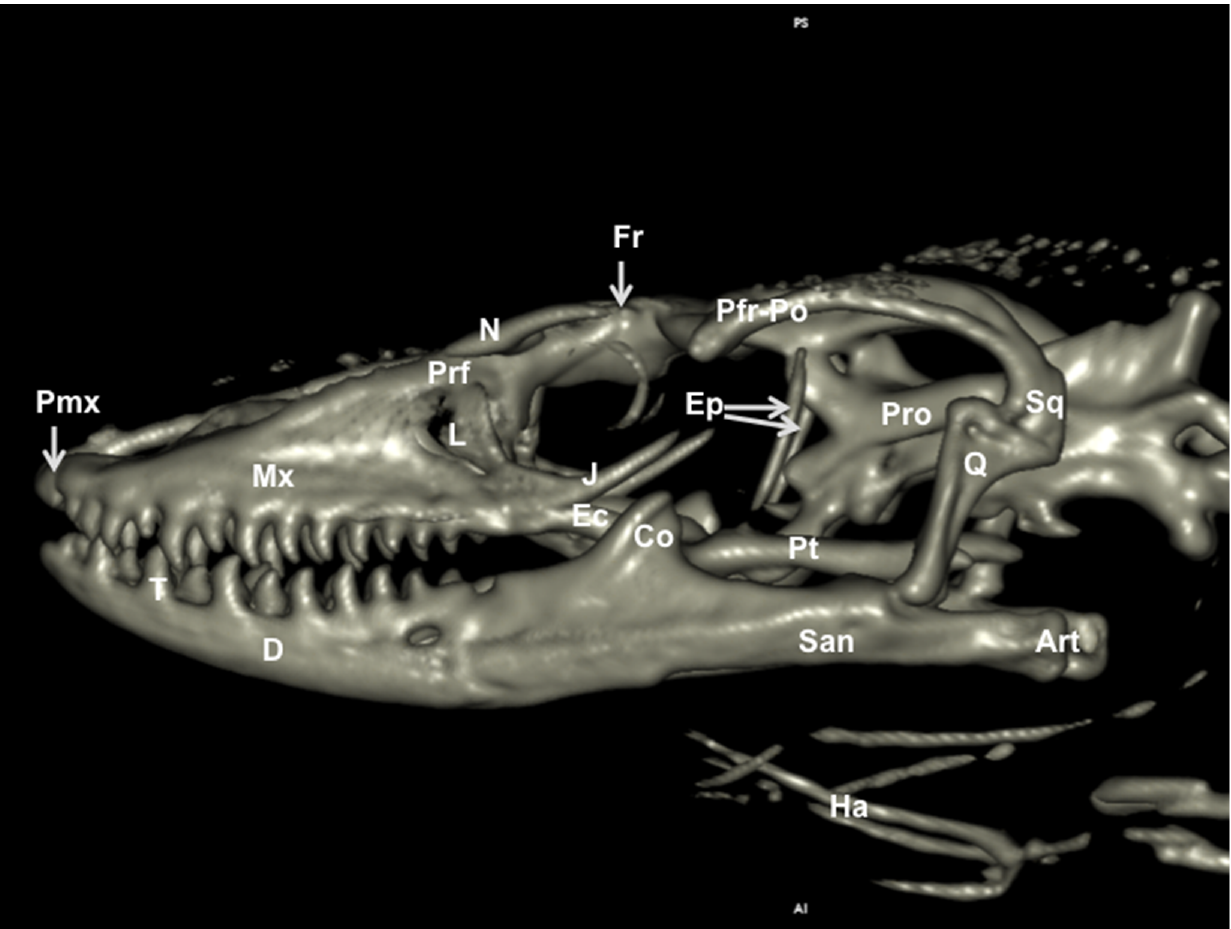
Figure 9. Three-dimensional volume-rendered reconstruction image of the cranium of Varanus komodoensis . Lateral aspect. Pmx: Premaxillary bone. Mx: Maxillary bone. Prf: Prefrontal bone. N: Nasal bone. Fr: Frontal bone. L: Lacrimal bone. J: Jugal bone. Ec: Ectopterygoid bone. Pt: Pterygoid bone. Ep: Epipterygoid. Q: Quadrate bone. Sq: Squamosal. Pfr-Po: Postfrontal + postorbital. Pro: Prootic. D: Dentary bone. T: Tooth. San: Surangular bone. Art: Articular bone. Co: Coronoid bone. Ha: Hyoid apparatus.